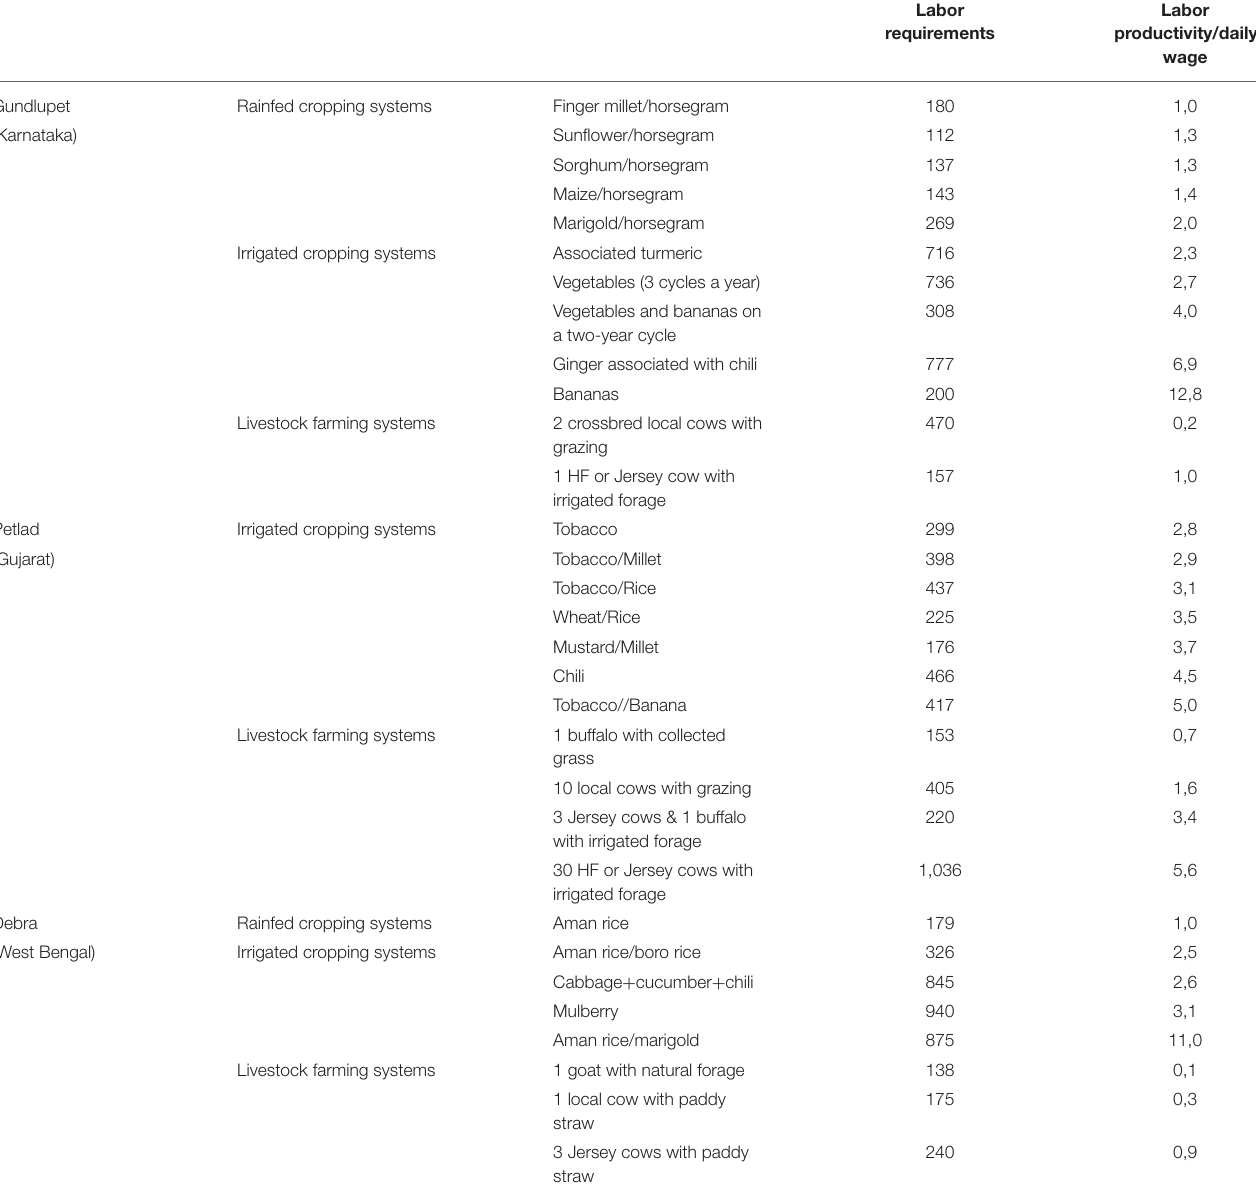
TABLE 1 | Labor requirements and ratio between daily labor productivity and agricultural wage for the main cropping and livestock farming systems of three study